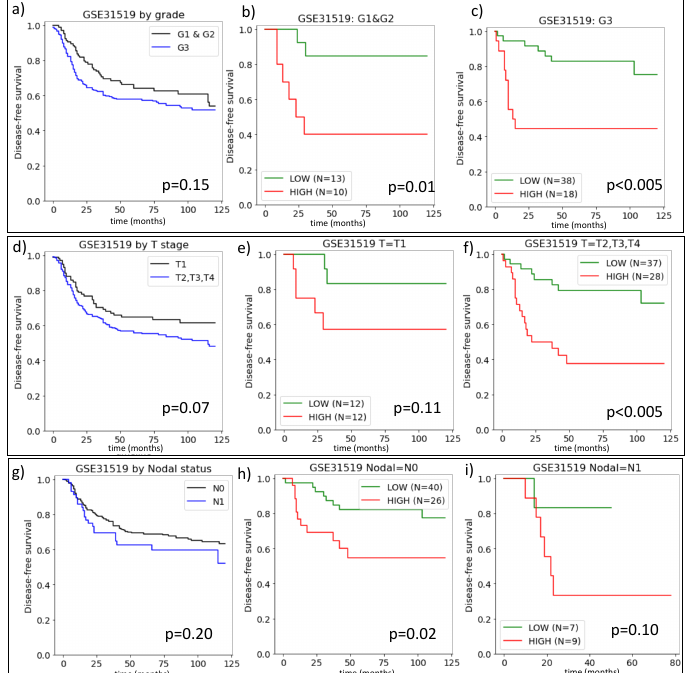
Figure 1. Stratification of TNBC patients according to standard pathologial classifications in grades and stages compared with EMT-based ARIADNE classification: Kaplan–Meyer plots for TNBC patients stratified according to ( a – c ) tumor grade G, ( d – f ) tumor stage T and ( g – i ) nodal (N) status. We report the survival curves first stratified by G, T and N ( a , d , g ) and then the stratification of individual pathological classifications (i.e., by G, T,N) by ARIADNE. The results showed that ARIADNE was able to better stratify patients, even within individual